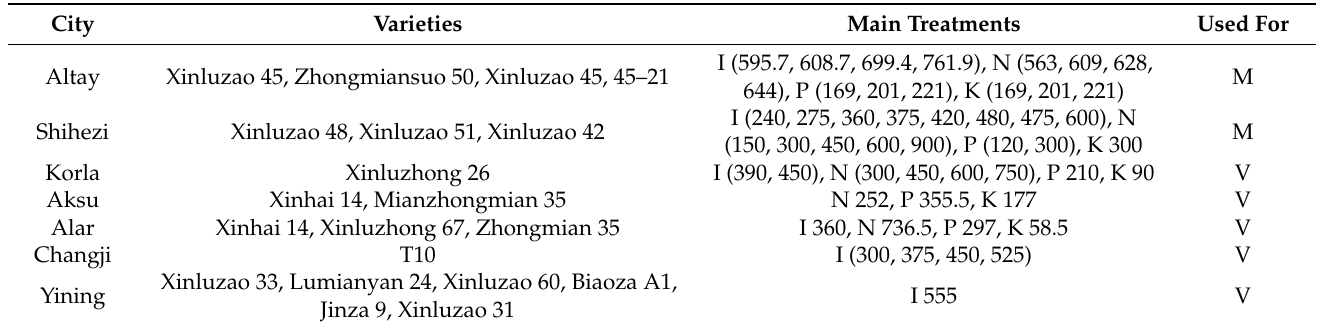
Table 8. Varieties and Main Treatments at Each Site for Cotton in China. N, N fertilisation (kg · hm − 2 ); P, P fertilisation (kg · hm − 2 ); K, K fertilisation (kg · hm − 2 ); I, Irrigation (mm); M, modelling; V, validation. Main Treatments Used